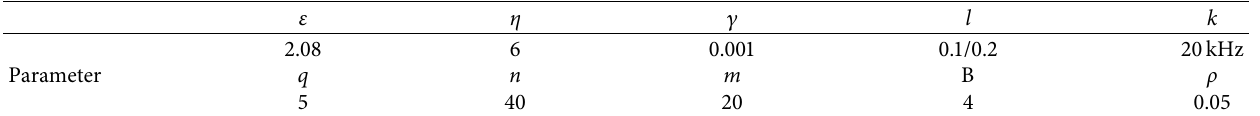
Table 2: Experiment